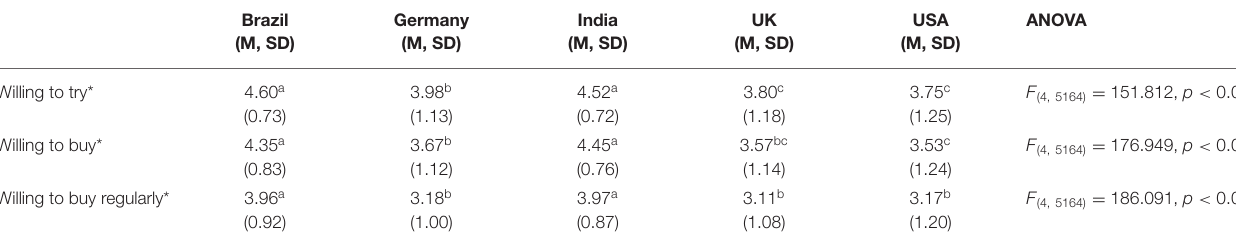
TABLE 1 | ANOVAs showing differences between countries in animal-free dairy enthusiasm.